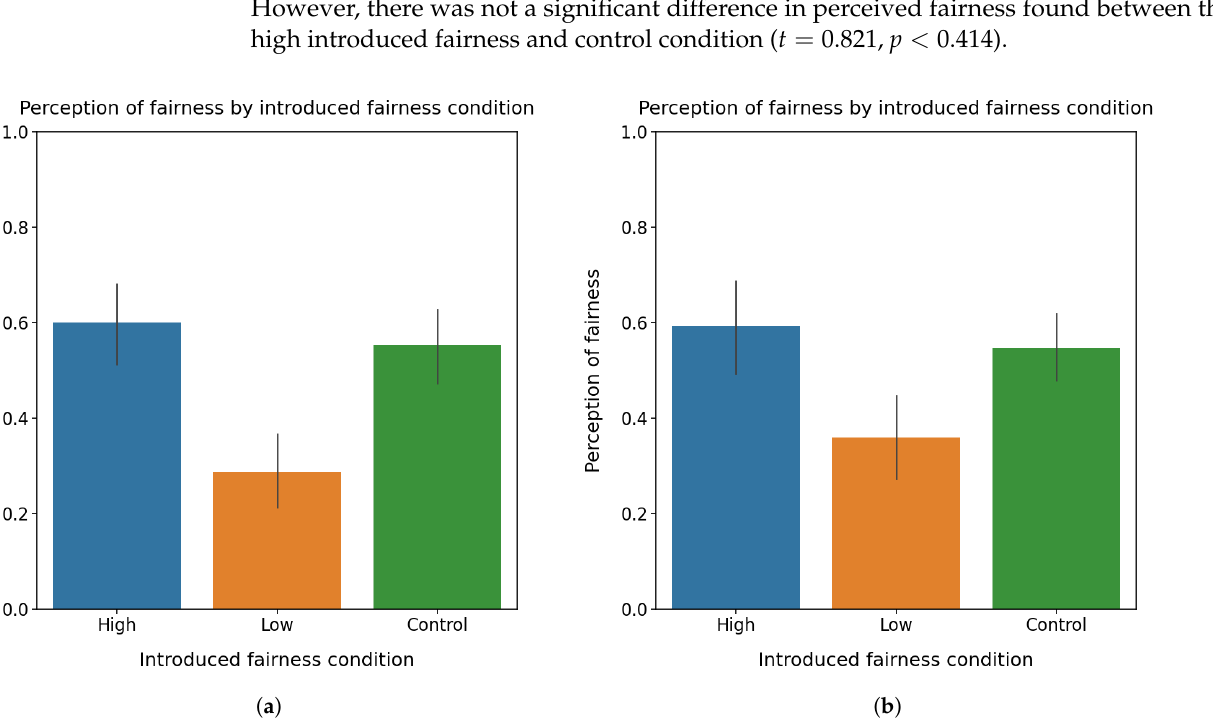
Figure 7. Perception of fairness per introduced fairness. ( a ) perception of fairness per introduced fairness levels under example-based explanations; ( b ) perception of fairness per introduced fairness levels under feature importance-based